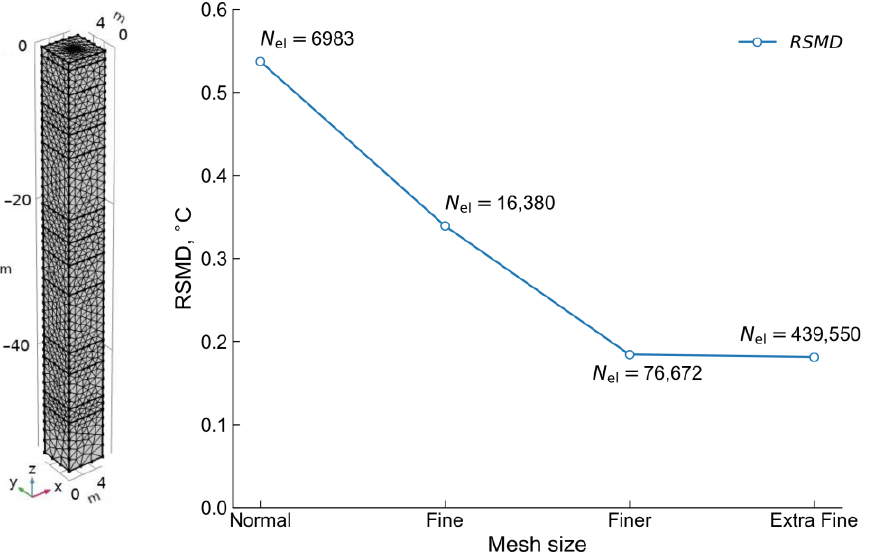
Figure 10. Comparison of the numerical and experimental data for 𝑇 𝑜𝑢𝑡 of HTF in BHE.